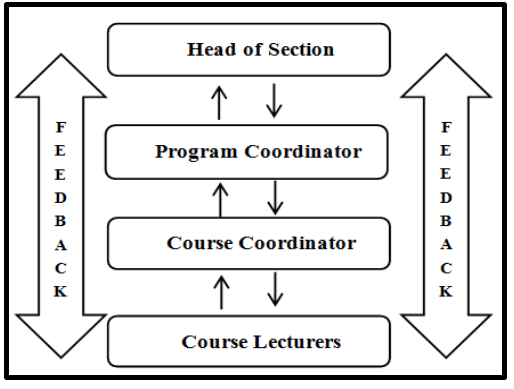
Fig. 1. Organizational Structure and Protocol (Course